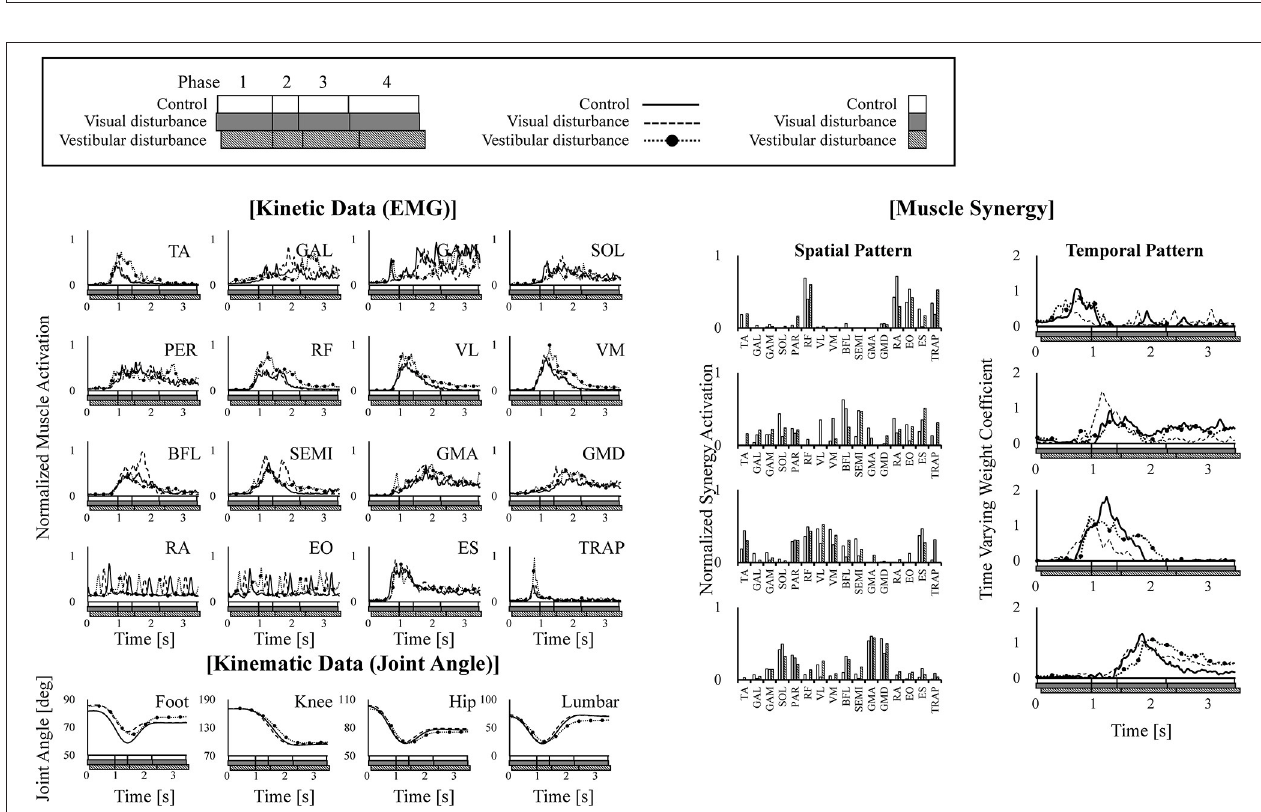
FIGURE 3 | Example of kinematic (joint angle) and kinetic (EMG) data are shown in the left of the figure. The extracted four muscle synergies are shown in the right of the figure. The joint angles are defined as the angle between the link and the horizontal axis. The data obtained under control, visual-disturbance, and vestibular-disturbance conditions are shown as solid, dashed, and dotted lines with circle markers, respectively. In each graph, white, gray, and black squares with diagonal lines below the horizontal axis, respectively show duration time of four phases.